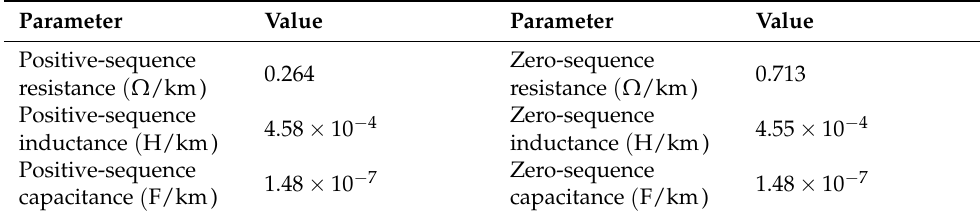
Table A1. Parameters of cables in the wind plants.